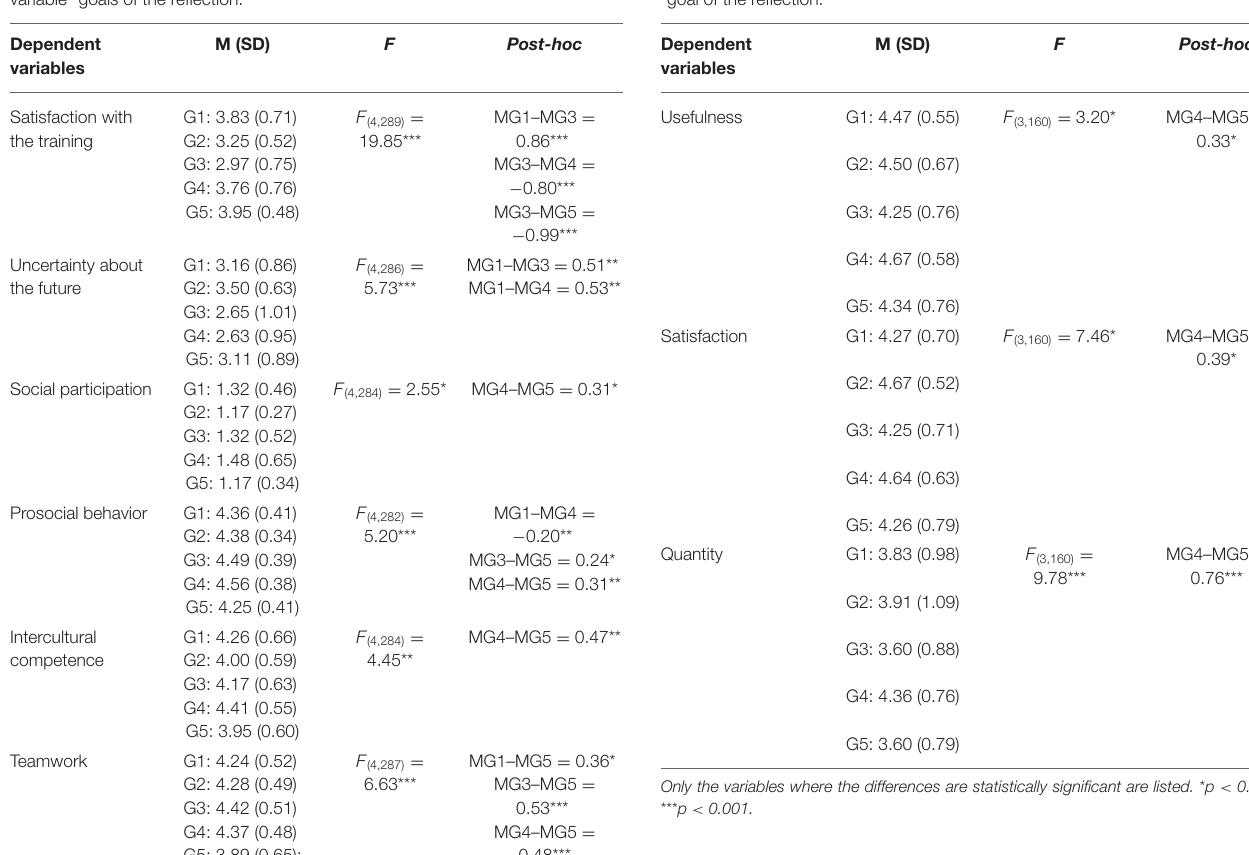
TABLE 7 | ANOVA oneway of the learning variables according to the variable “goal of the reflection.” Dependent variables